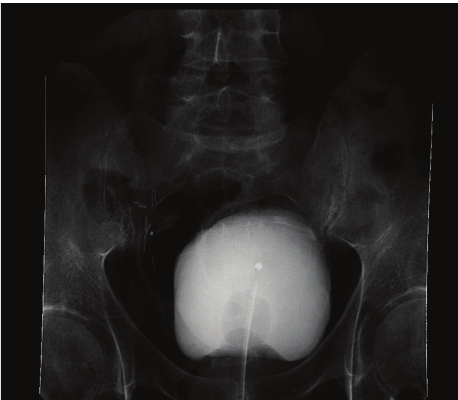
Figure 6: A control cystography six weeks postoperatively revealed no contrast leakage